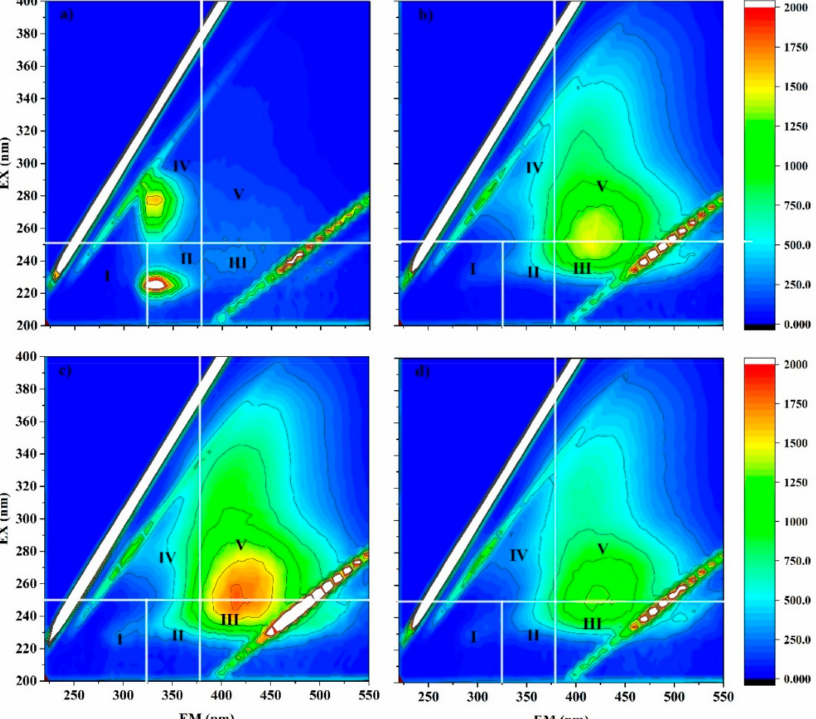
Figure 6. Fluorescence excitation–emission matrixes (EEM) of the selected water samples from the wet season. Region I: Aromatic Protein I; Region II: Aromatic Protein II; Region III: Fulvic acid-like substances; Region IV: Soluble microbial by-product-like substances; Region V: Humic acid-like substances. ( a ) Sample 5, ( b ) sample 9, ( c ) sample 21 and ( d ) sample